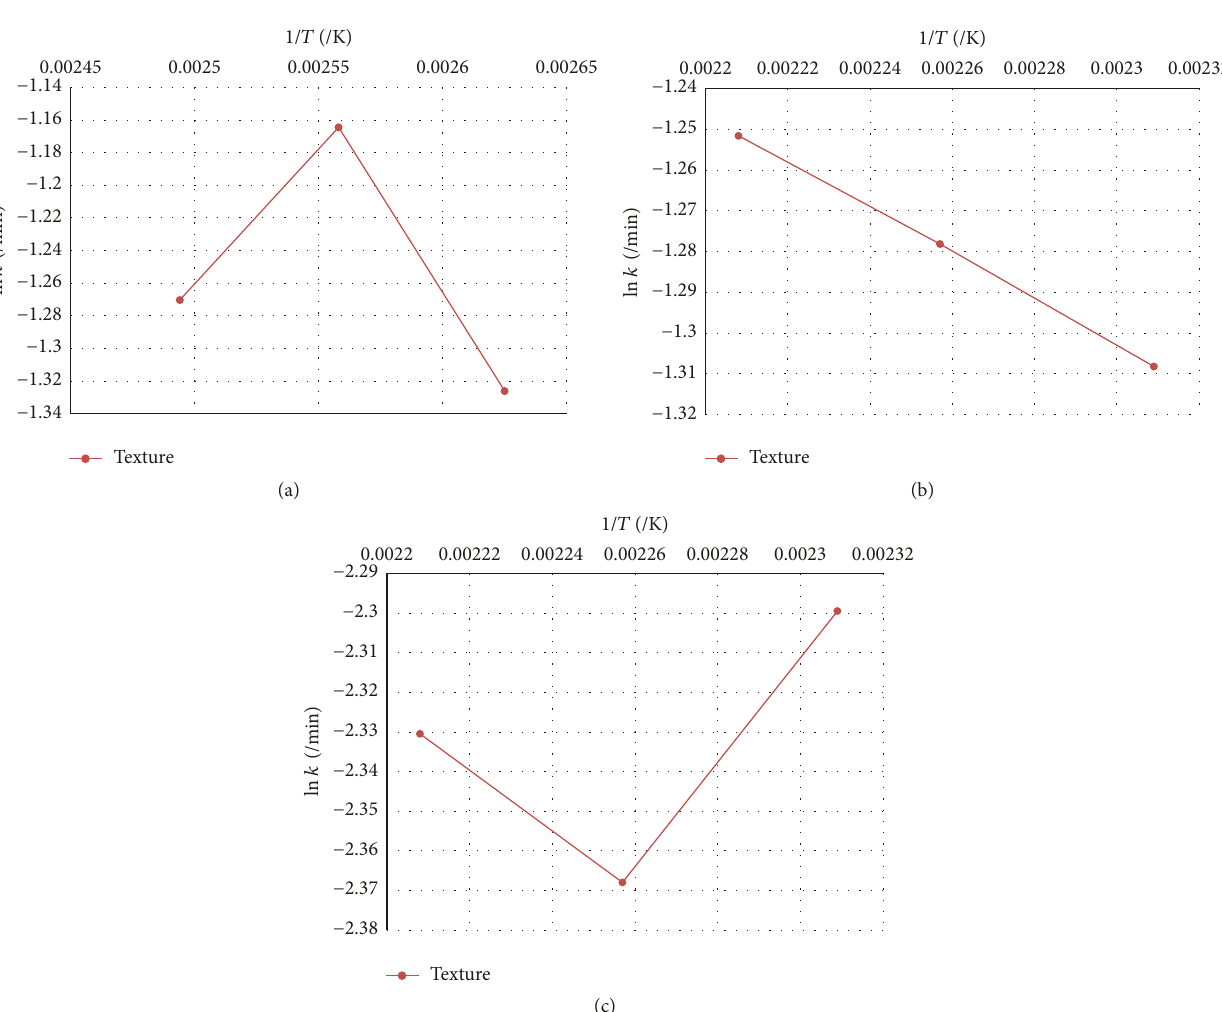
colour change is because the magnitudes of these parameters generally decrease as frying temperature increases.